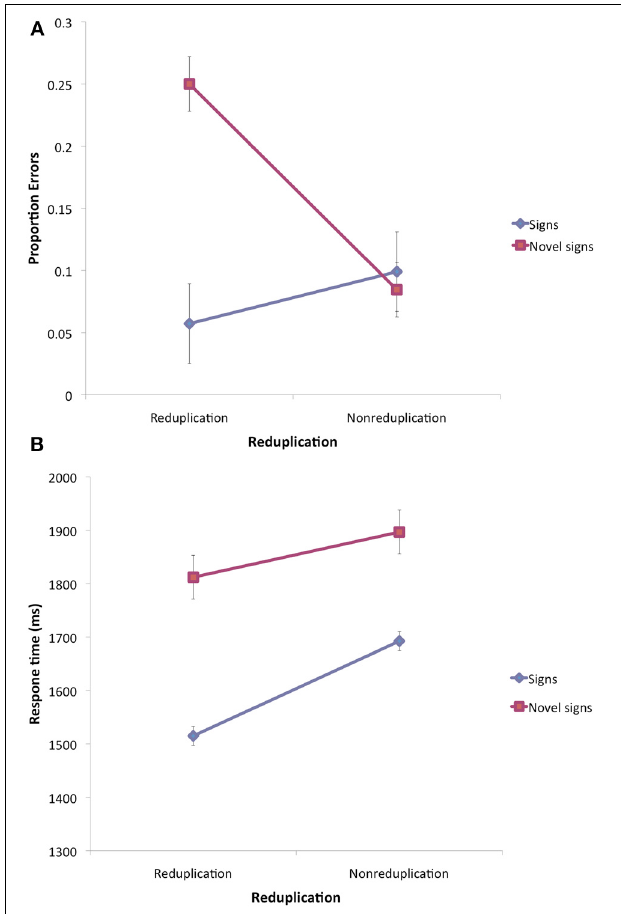
FIGURE 3 | Lexical decision results for ASL signs and novel signs with native ASL features in Experiment 2. Note: Error bars are 95% confidence intervals for the difference between the means.